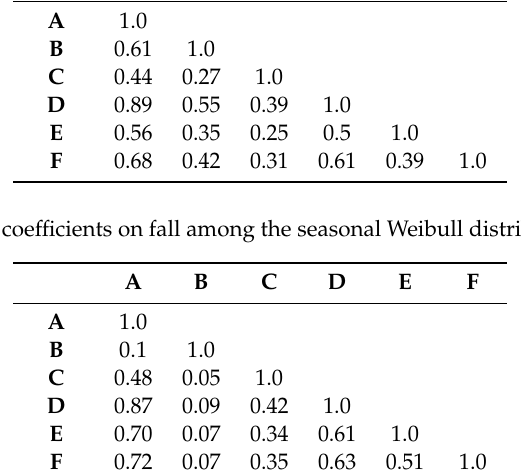
Table 5. The correlation coe ffi cients on summer among the seasonal Weibull distributions of the six farms. A